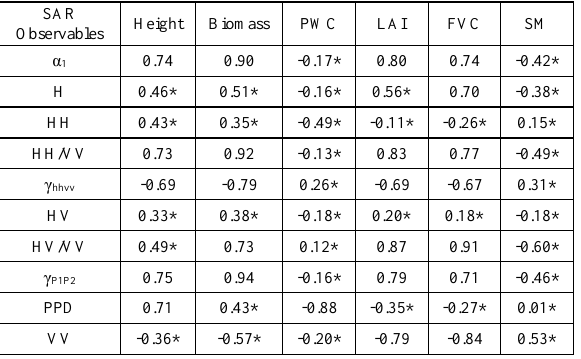
Table 2. Correlation (R Pearson) between SAR observables and field estimations for J12 (wheat). Non-significant correlations at 95% confidence level are indicated by *.